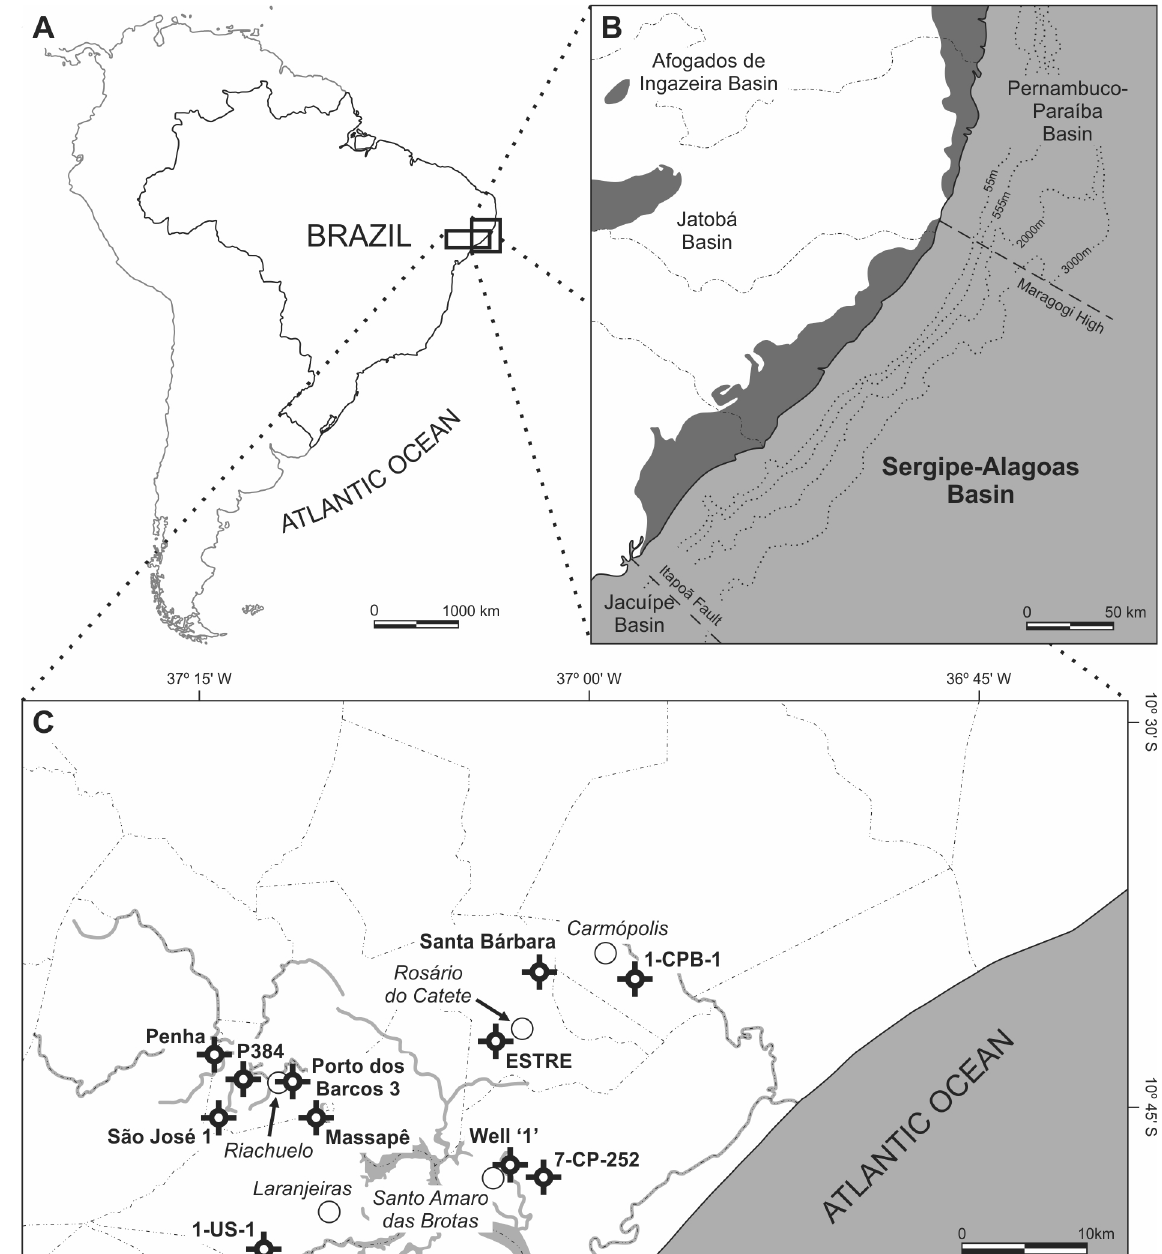
Fig. 1. Location of the Sergipe-Alagoas Basin in South America and Brazil, along with the outcrops and wells studied in the present